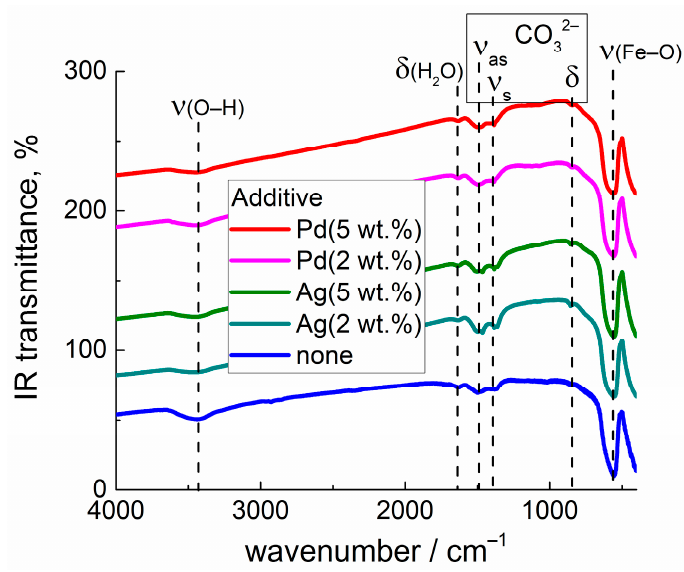
Figure 4. FTIR spectra of pristine and Ag- or Pd-modified LaFeO 3 .